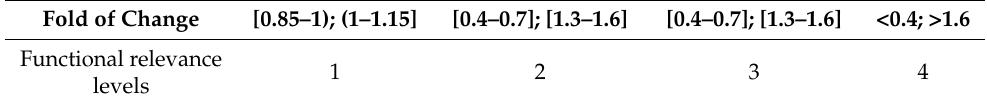
Table 1. Fold of change values associated with the defined functional relevance levels. Fold of Change